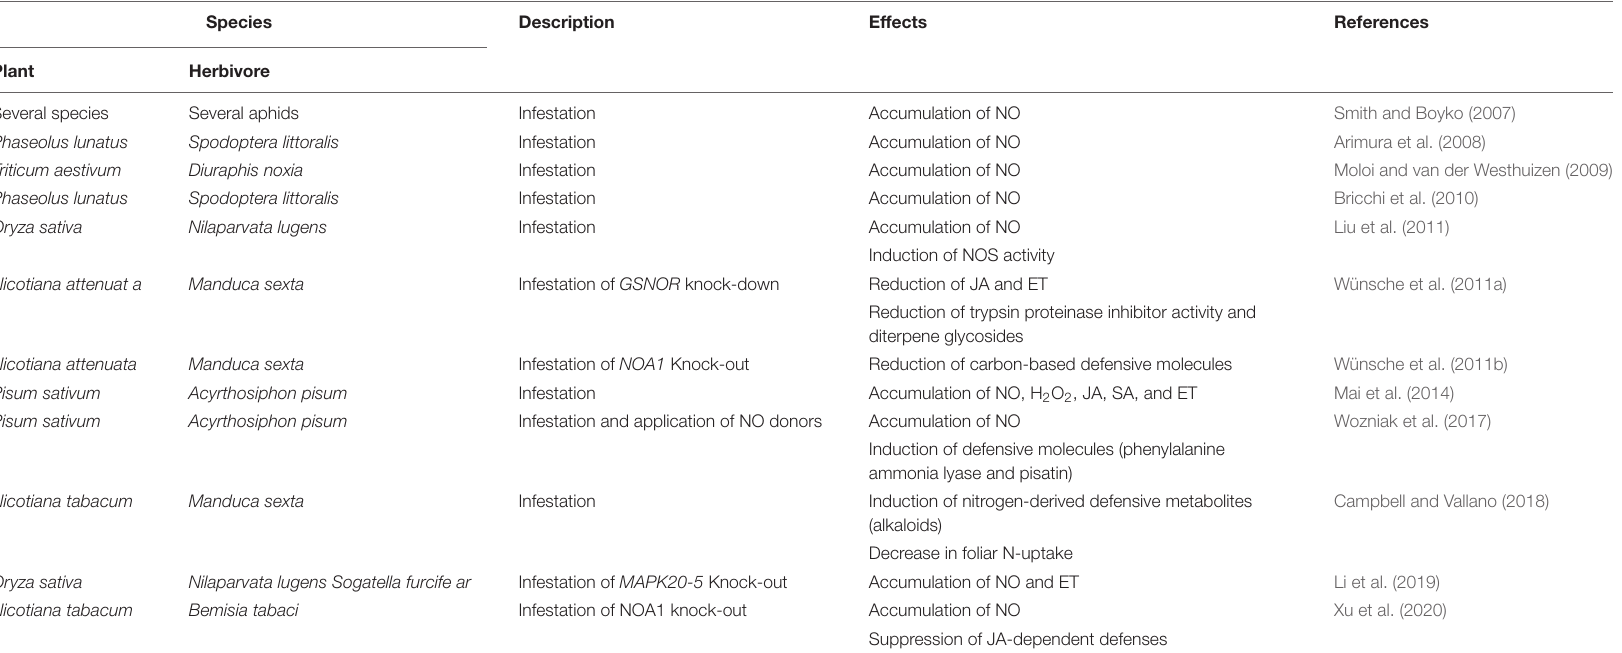
TABLE 1 | Participation of NO and NO-related enzymes in the plant defenses against phytophagous